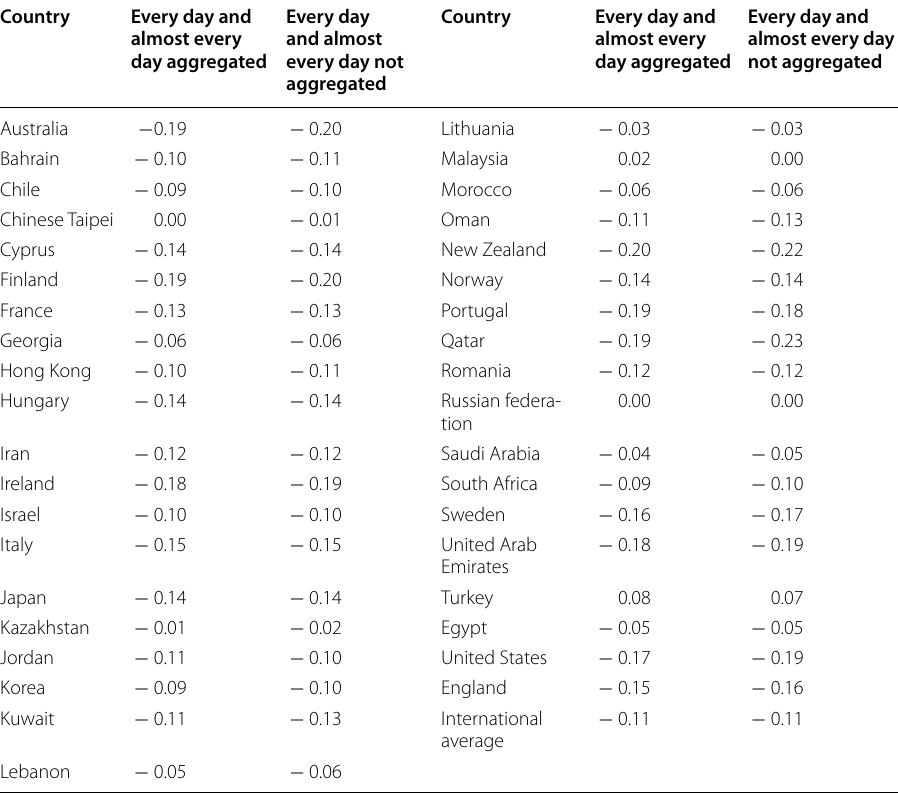
Table 4 Correlation between Frequency of Hunger and Student Achievement with and without aggregating “Every Day” and “Almost Every Day” Response Categories